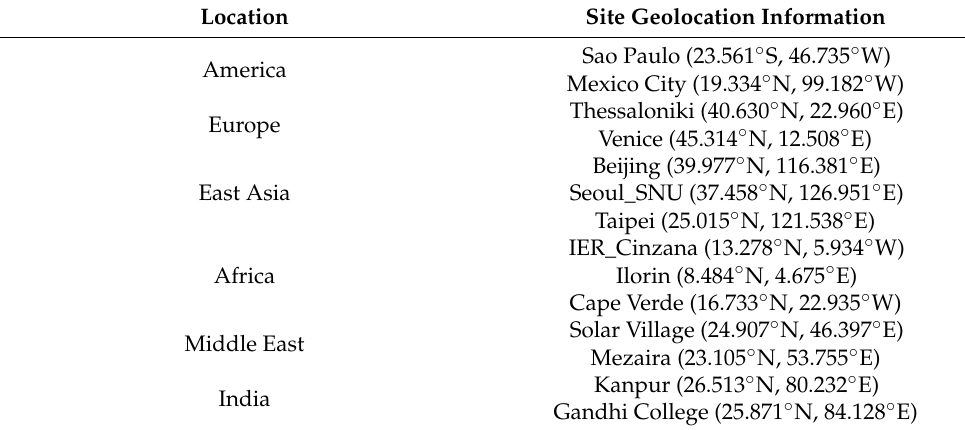
Table 1. The geolocation information of the selected AERONET